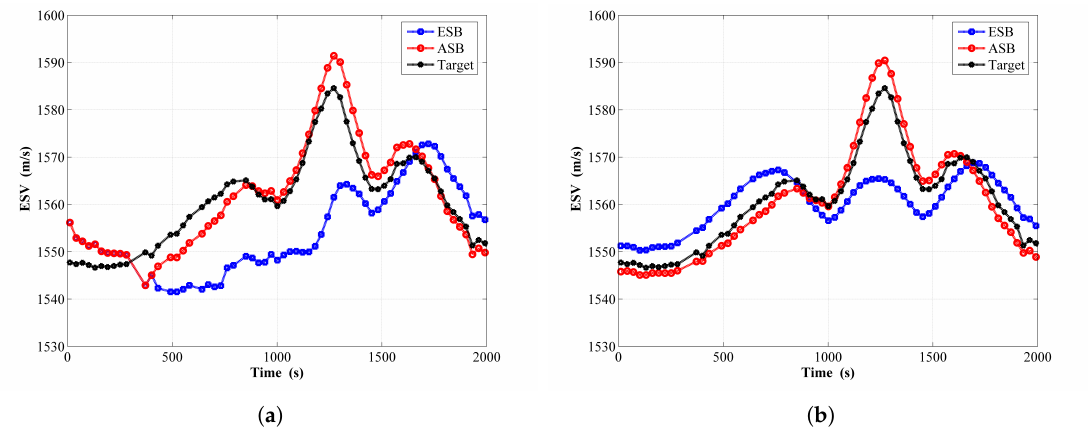
Figure 14. Estimated ESV by the ESB and the ASB algorithms using field data with unknown Q k : ( a ) Filter; ( b ) RTS